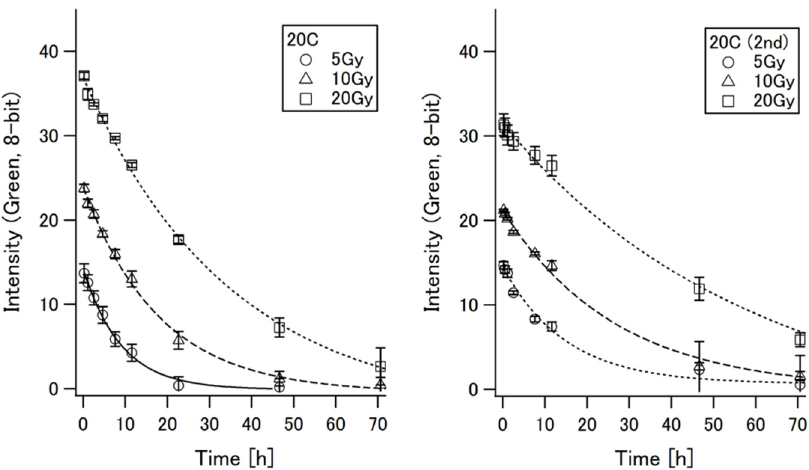
Figure 6. Comparison of the time changes of the green component of PAISiN at room temperature (20 °C) between repeated γ -ray irradiations: 1st ( left ) and 2nd ( right ); 2nd irradiation was made about 1 month later than the 1st one.